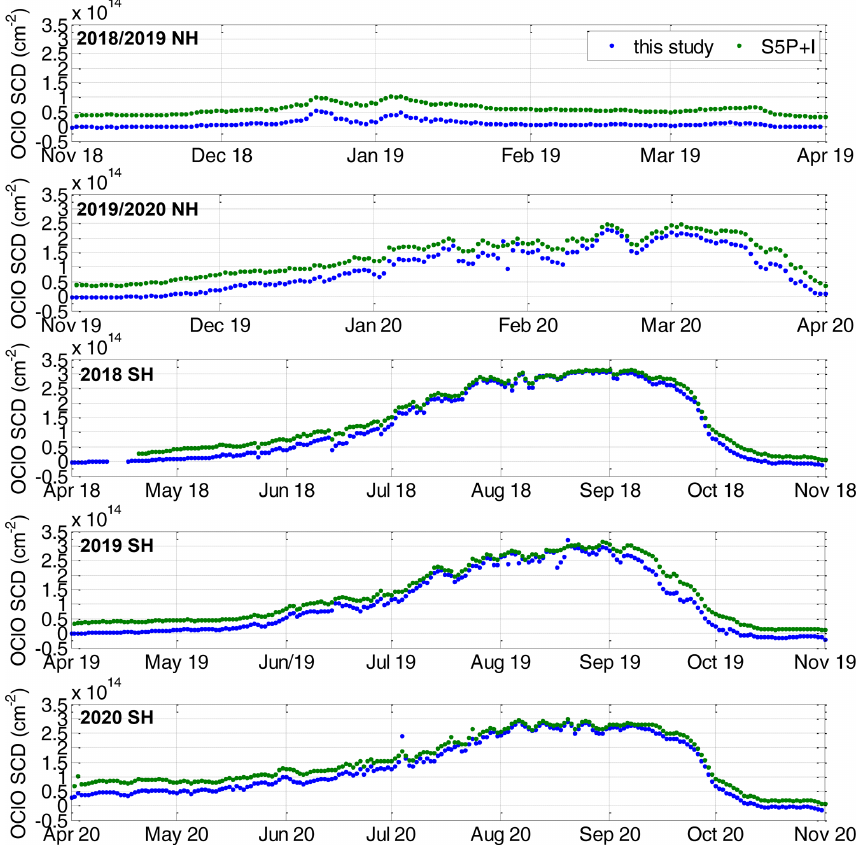
Figure 10. Time series of TROPOMI mean OClO SCDs within 89 ◦ < SZA < 91 ◦ obtained within this study and the preliminary data from the operational S5P+I data for polar winters (from top to bottom) 2018/19 and 2019/20 in the NH and 2018, 2019, and 2020 in the SH.